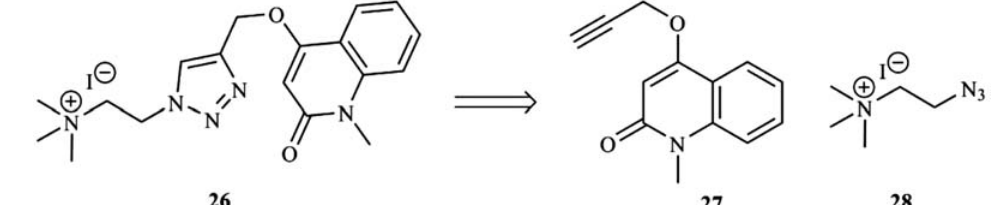
Figure 14. Compound 26 with high affinity to Lymnaea stagnalis , Aplysia californica , and the Y55W Aplysia californica mutant AChBPs and con- stituent alkyne 27 and azide 28 shown in retrosynthetic representation. 124